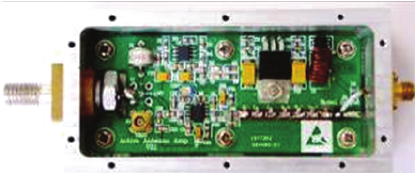
Figure 9: Gain variation of the active receiving antenna with frequency.